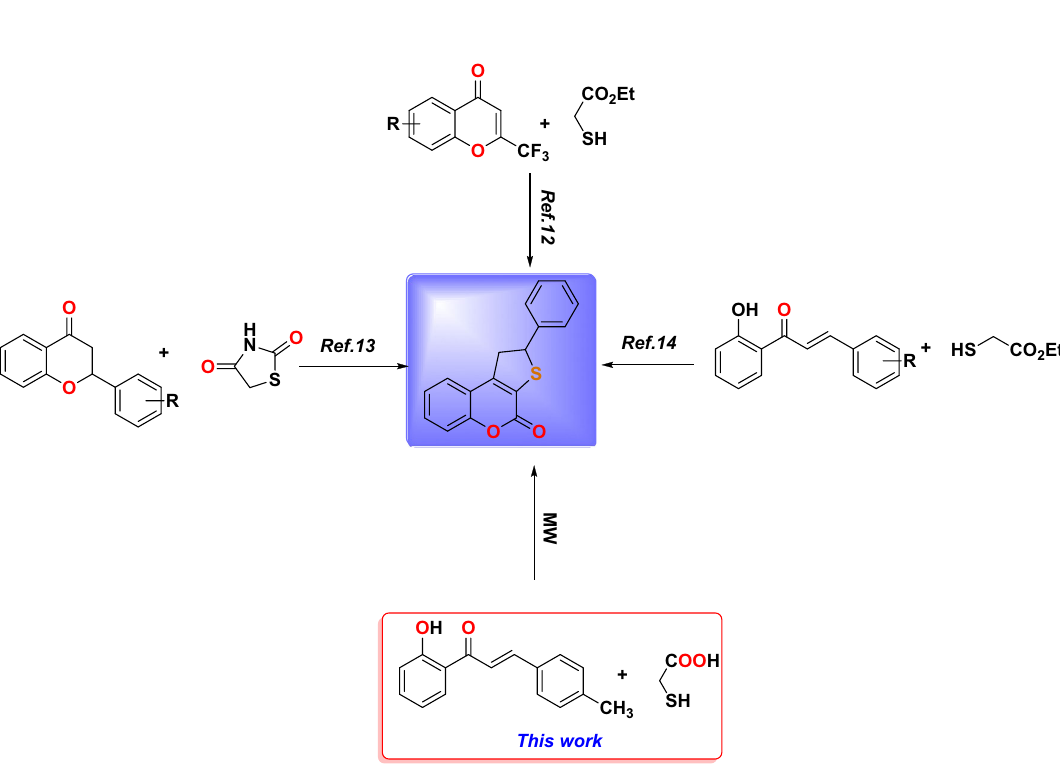
Figure 2. Strategies and synthetic routes used for the synthesis of 1,2-dihydrothieno[2,3- c